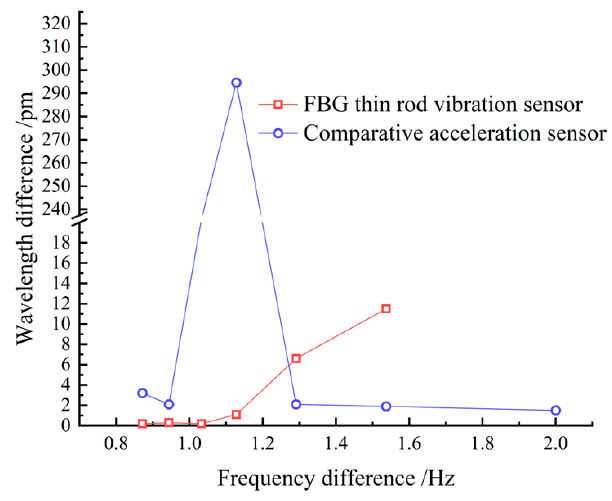
Figure 12. Sensitivity of the two sensors. Table 1. Indoor cable tension test data.